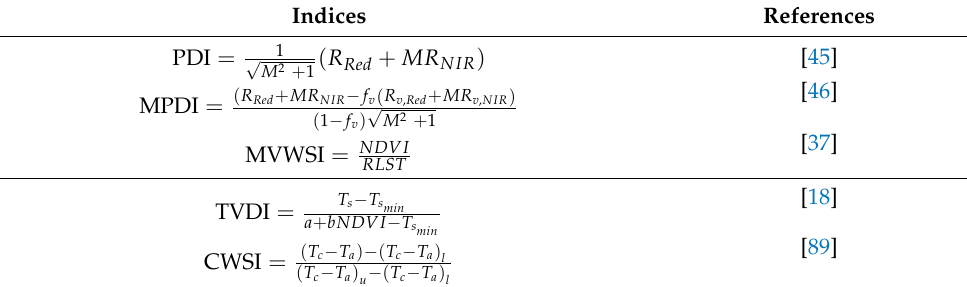
Table 1. Indices evaluated against TVWSI. For Perpendicular Dryness Index (PDI) and modified Perpendicular Dryness Index (MPDI), R Red , R NIR represents the reflectance in red and NIR region, R v , Red , R v , NIR represents vegetation reflectance in Red and NIR region, M represents the slope of the soil line, f v represents vegetation fraction. For Modified Vegetation Water Supply Index (MVWSI), RLST represents the ratio of LST with its long-term mean. For Temperature Vegetation Dryness Index (TVDI), T s and T s represents surface temperature and minimum temperature along the min wet edge, a and b are parameters defining the dry edge. For the Crop Water Stress Index (CWSI), ( T c − T a ) represents the temperature difference between canopy and air, ( T c − T a ) l represents the lower non-water-stressed boundary, and ( T c − T a ) u represents the upper reference non-transpiring condition boundary.